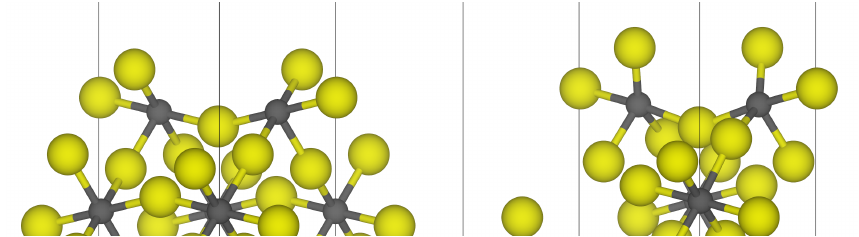
Figure 5. α -AlF 3 - ( 11¯20 ) surface: unrelaxed surface cut of the most stable termination ( left ) and corresponding structurally-optimized surface ( right ). Grey = aluminum, yellow = fluorine.